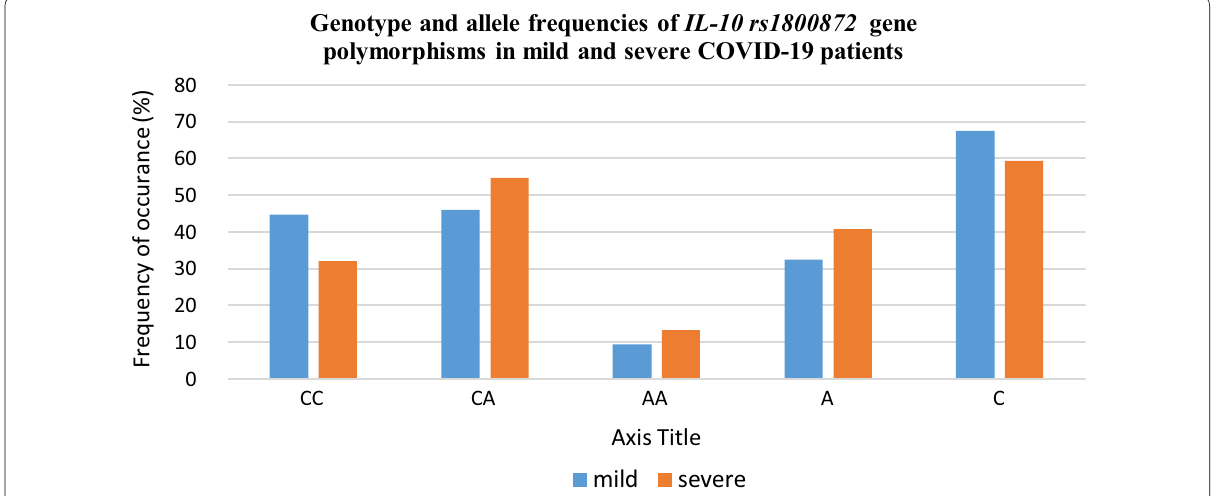
Fig. 2 Graphical representation of genotype and allele frequencies of IL-10 rs1800896 gene polymorphisms in COVID-19